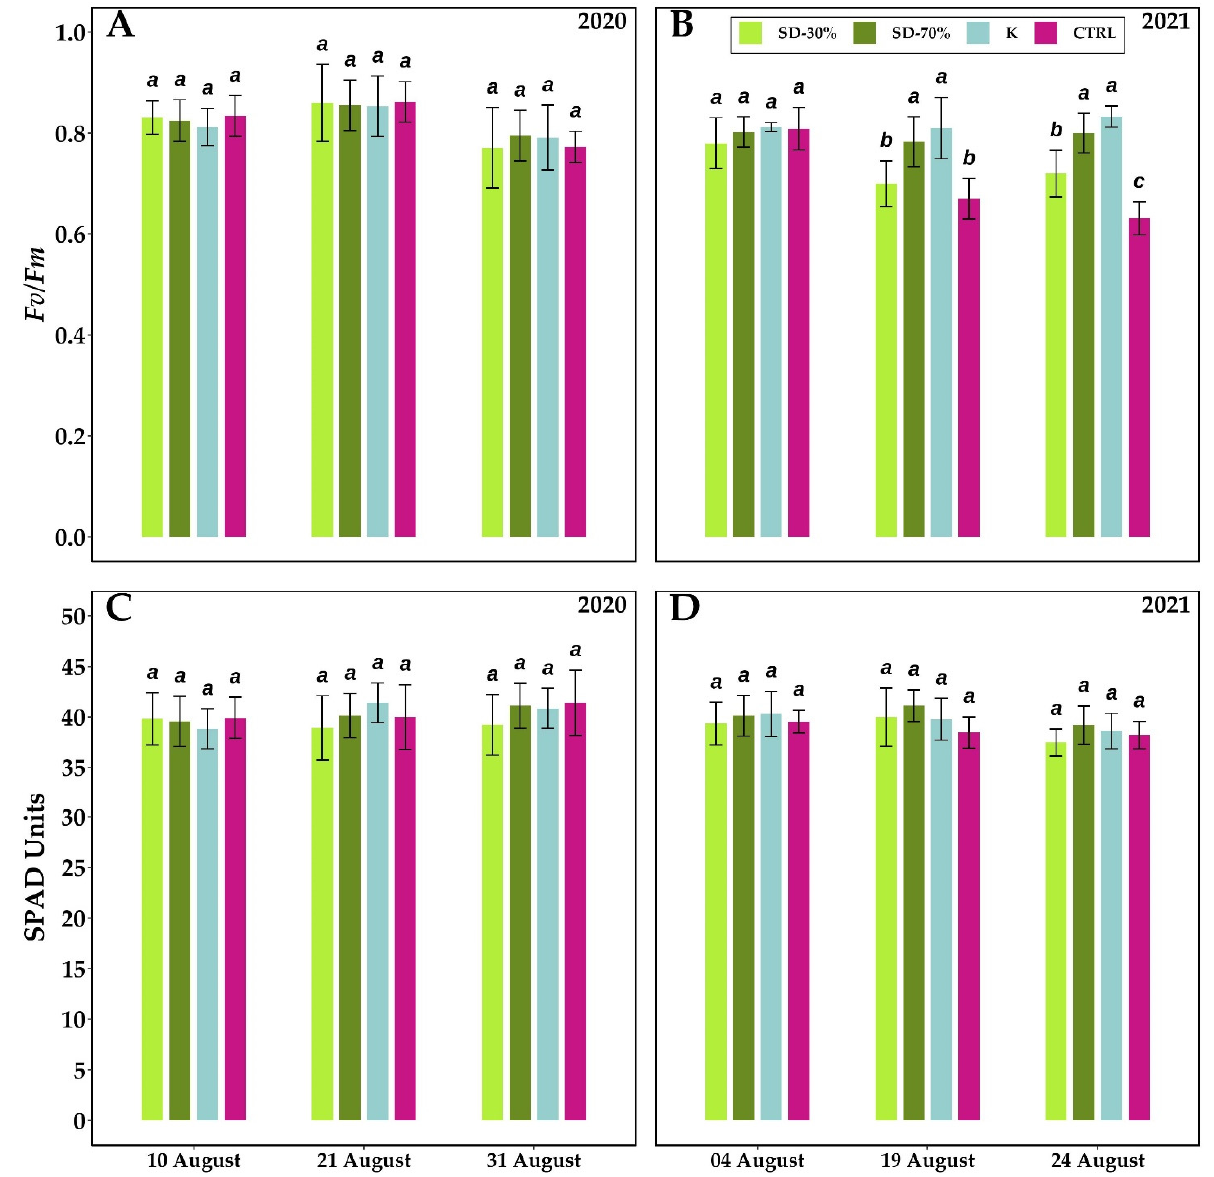
Figure 5. Maximum quantum yield of PSII ( Fv / Fm ) (( A ), 2020; ( B ), 2021) and chlorophyll content (( C ), 2020; ( D ), 2021) of V. vinifera with four different canopy management: SD-30% (green artificial shading net at 30%; light green columns), SD-70% (green artificial shading net at 70%; dark green columns), K (kaolin; light blue columns), and CTRL (control; purple columns). Measurements were conducted at full veraison (10 August 2020 and 4 August 2021), mid maturation, berries with inter- 24 August 2021). Data (mean ± SE, n = 10) were subjected to one-way ANOVA. In each measured parameter ( Fv/Fm and SPAD) the statistical difference is represented by letters; within the single date, a grouping of columns, the statistical differences between the treatments (SD30%, SD70%, K, and CTRL) are represented by different letters (a, b, c) (LSD test, p ≤ 0.05). The same letter pictured on different treatments indicates no significant difference among them.